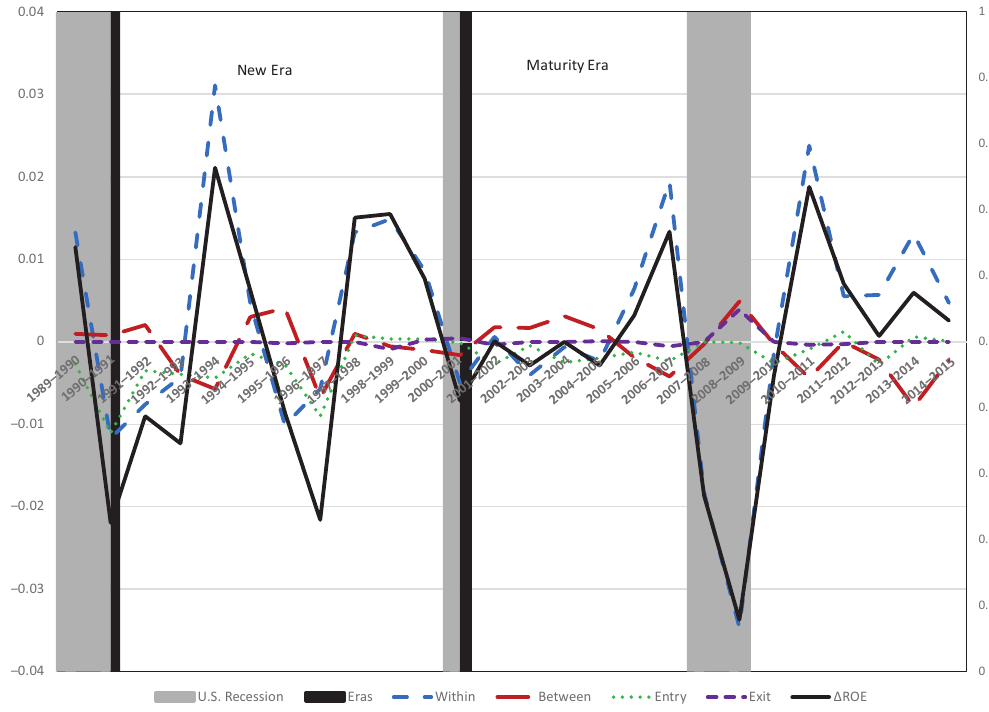
Figure 2. Evolution of the Bennet decomposition effects,